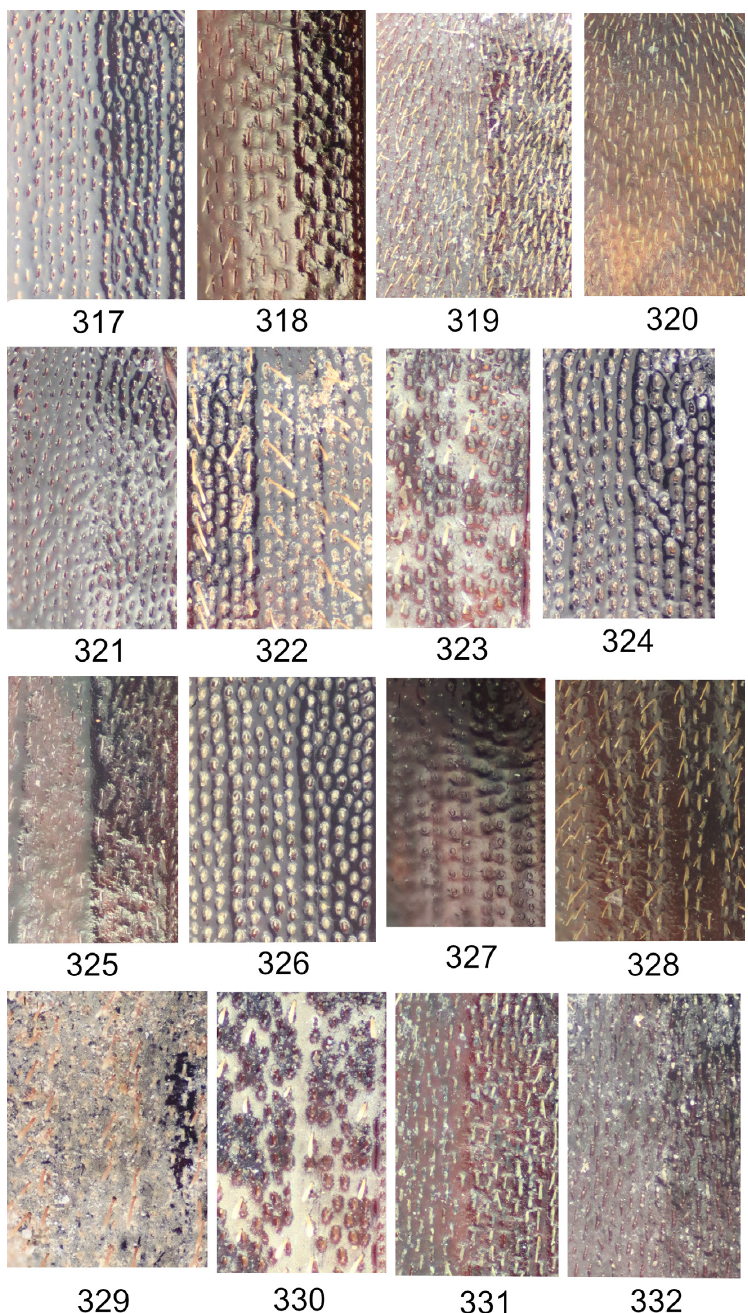
Figs 317–332. Papuan and Wallacean Maechidius Macleay, 1819, elytron, dorsal view. 317 . M. lineatopunctatus Frey, 1969, holotype, ♂ (NHMB). 318 . M. lobaticeps Frey, 1969, ♂ (DTC). 319 . M. longipes sp. nov., holotype, ♂ (BMNH). 320 . M. luniceps Fairmaire, 1883, ♂ (BMNH). 321 . M. mailu sp. nov., holotype, ♂ (NHMB). 322 . M. maleo sp. nov., holotype, ♂ (IRSN). 323 . M. merdeka sp. nov., holotype, ♂ (BMNH). 324 . M. miklouhomaclayi sp. nov., holotype, ♂ (NHMB). 325 . M. milneanus Heller, 1914, lectotype, ♀ (SNSD). 326 . M. muticus Arrow, 1941, syntype, ♂ (BMNH). 327 . M. nanus Arrow, 1941, syntype, ♂ (BMNH). 328 . M. nepenthephilus sp. nov., holotype, ♂ (NME). 329 . M. opatroides Arrow, 1941 comb. rest., lectotype, ♀ (BMNH). 330 . M. owenstanleyi sp. nov., holotype, ♂ (BMNH). 331 . M. papuanus Moser, 1926, lectotype, ♀ (ZMHB). 332 . M.